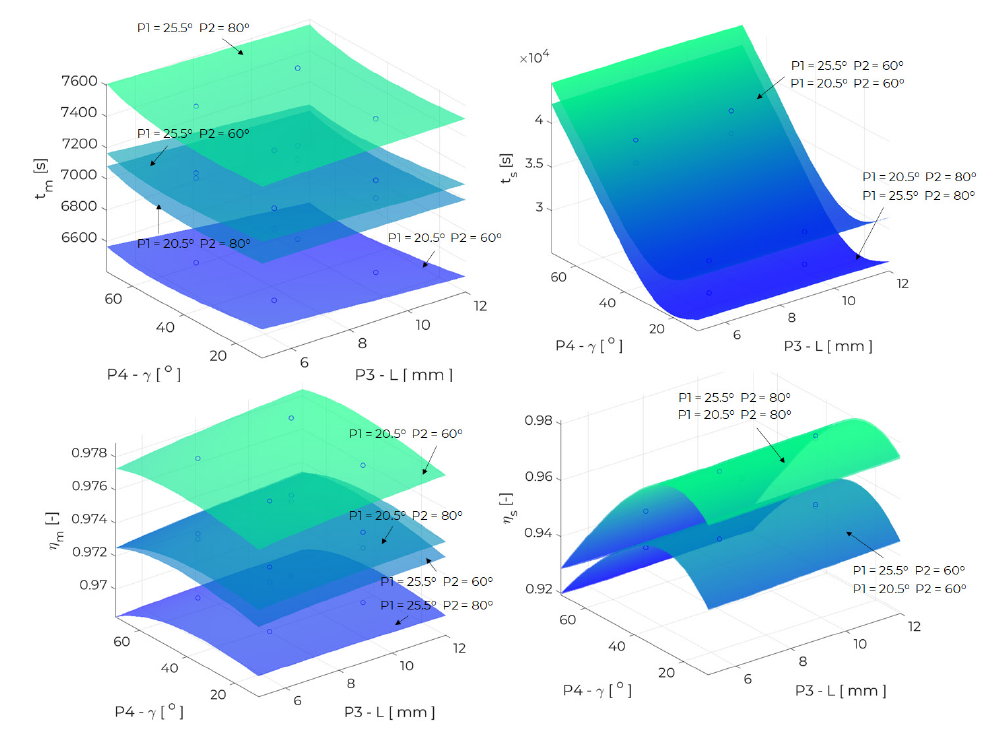
Figure 14. The response surface for inputs P3, P4, outputs t m , t s , η m , η s and (P1, P2) = [(20.5 ◦ , 60 ◦ ), (20.5 ◦ , 80 ◦ ), (25.5 ◦ , 60 ◦ ), (25.5 ◦ , 80 ◦